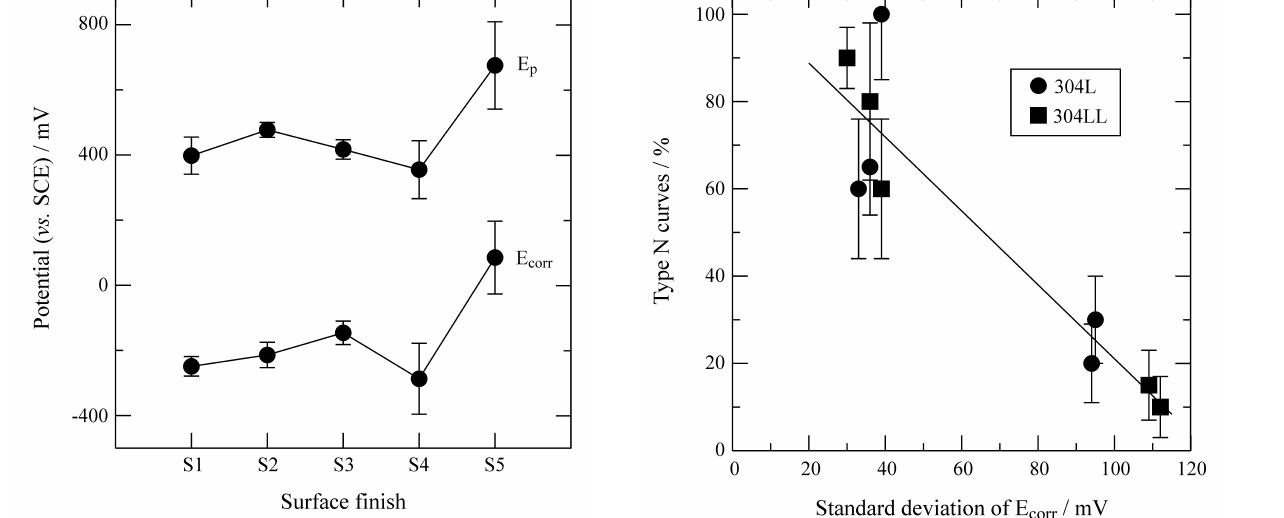
Figure 2. Pitting potential E p and corrosion potential E corr as a function of the surface finish for 304LL